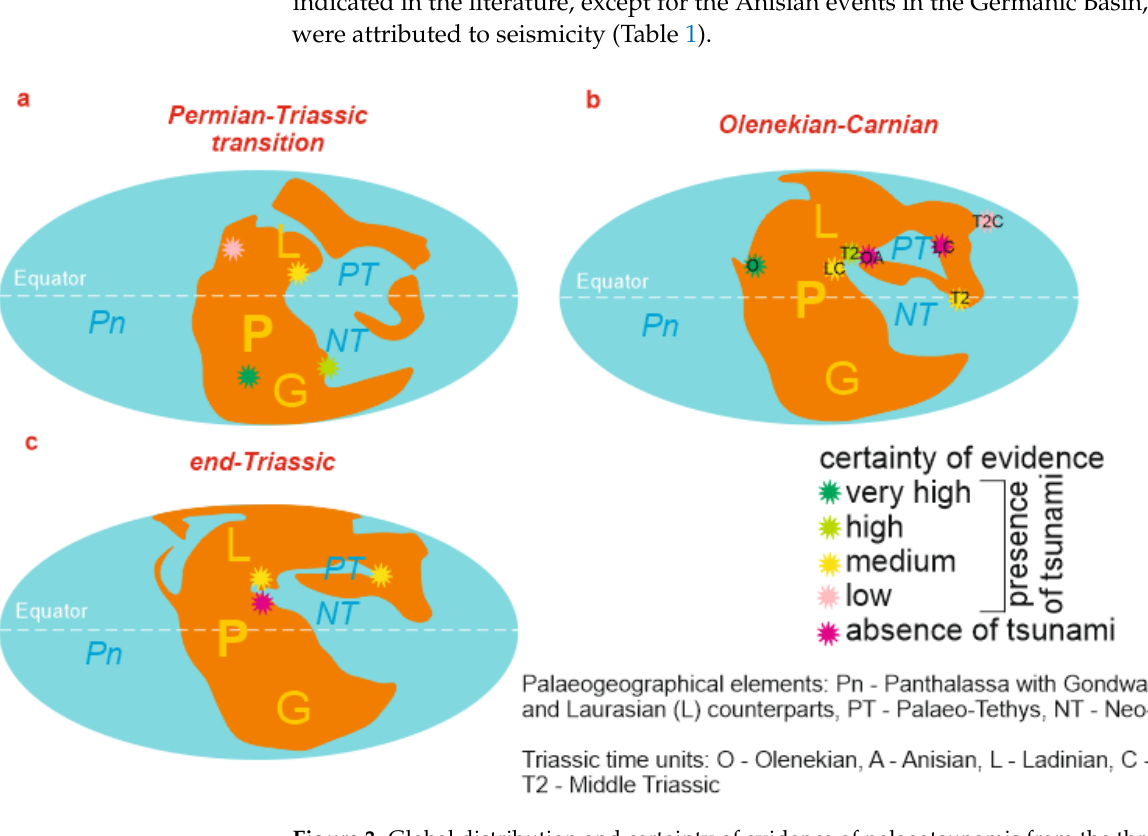
7 of 16 Figure 2. Lowermost Induan strata (Bambak Formation) of the Western Caucasus: simplified cross-section (above) and image of characteristic megaclast in sandstone bed (below) (the image is a part of the larger photograph from [57], and it is re-published with permission of MDPI). Tsunamis at the Permian–Triassic transition have been reported from several localities, from which the most studied is the Guryul Ravine in Kashmir (Table 1). However, the Parana Basin of Brazil is the only place where the evidence of palaeotsunami seems to be the most certain. For the other localities, alternative